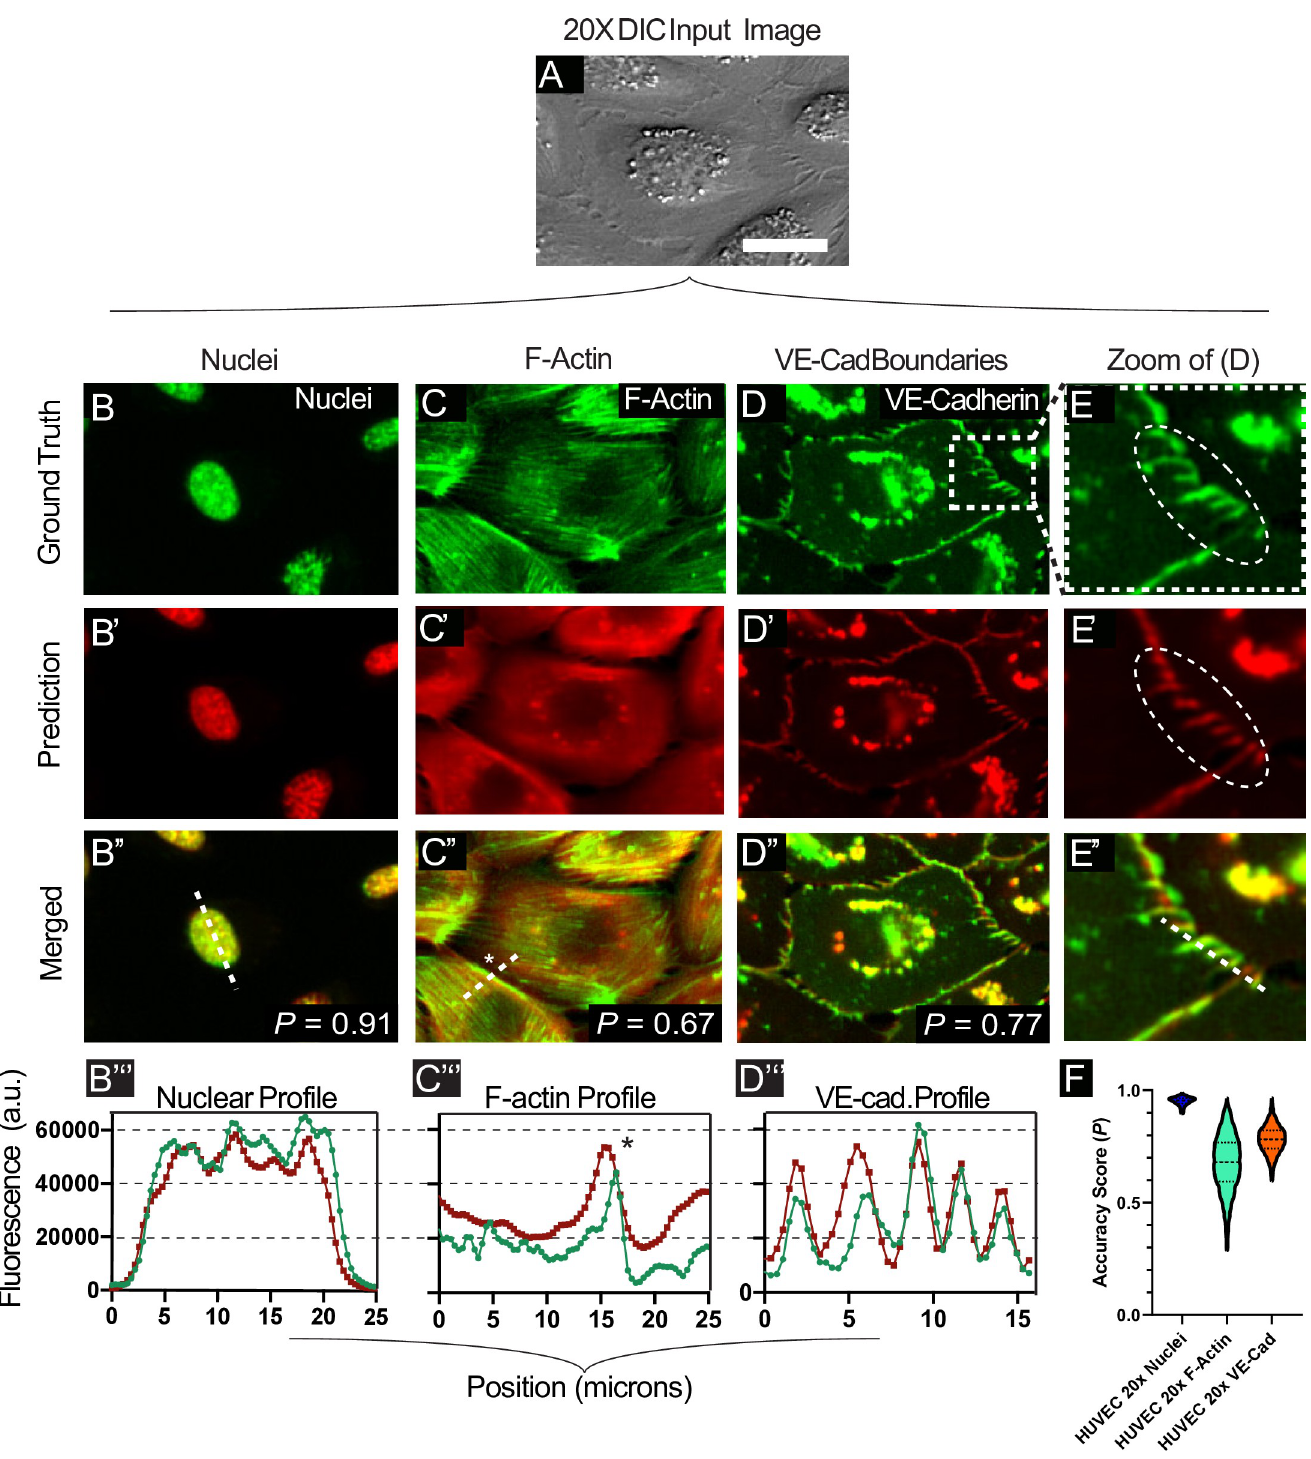
Fig 4. Coarse-to-fine feature reconstruction. (A) A representative transmitted-light image of HUVEC cells at 20x magnification with its corresponding structures of varying scale (B-D). The scale bar represents 30 μ m. (B-D) the relatively large nuclei, the finer VE-Cadherin structures, and thin F-Actin filaments which are not readily resolved by the network. Ground truth fluorescent features are displayed alongside, and merged with, network predictions. (E) displays zoomed-in portions of images shown in (D). Line sections from (B”, C”, and D”) are displayed graphically in (B”‘, C”‘, D”‘), to enable intensity comparisons across the ground truth and predicted features. (F) summarizes the distribution statistics, clearly showing the uncertainty in F-actin, with tighter reconstruction for nuclei and VE-cadherin. N = 5500+ test images for these